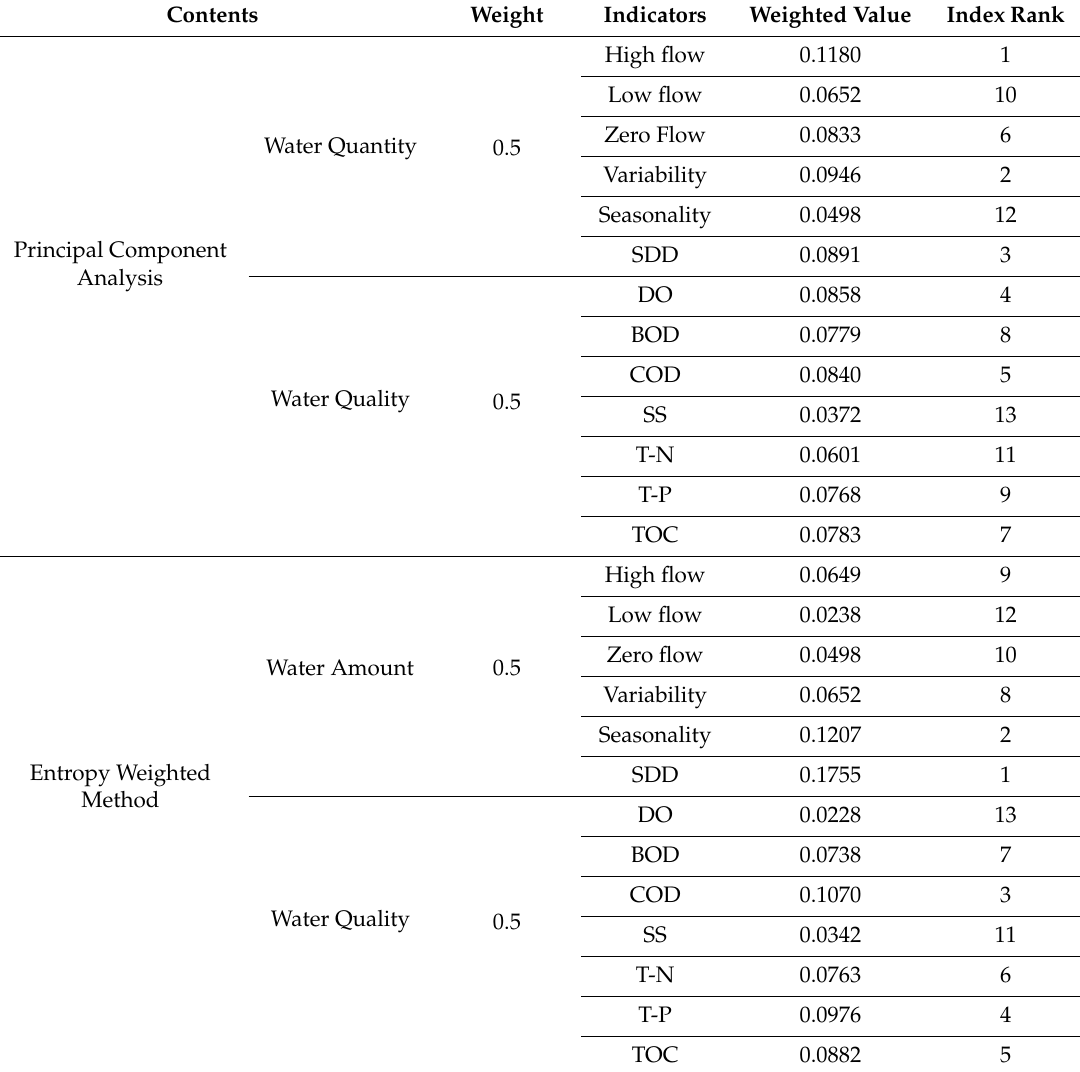
Table 14. Weighted results of